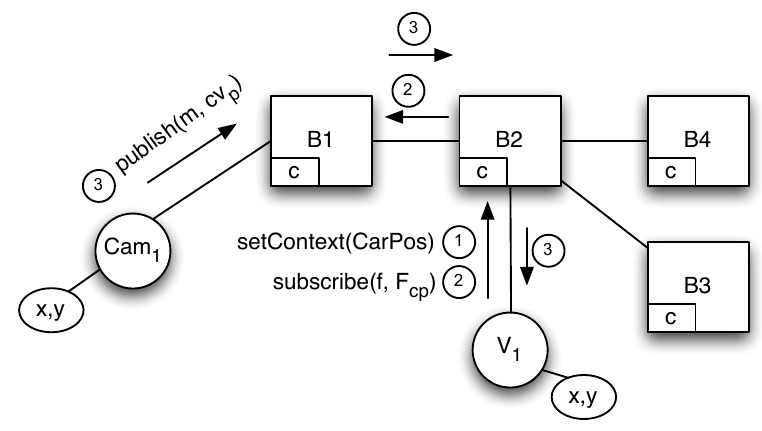
Figure 5. Adding a new subscriber to the